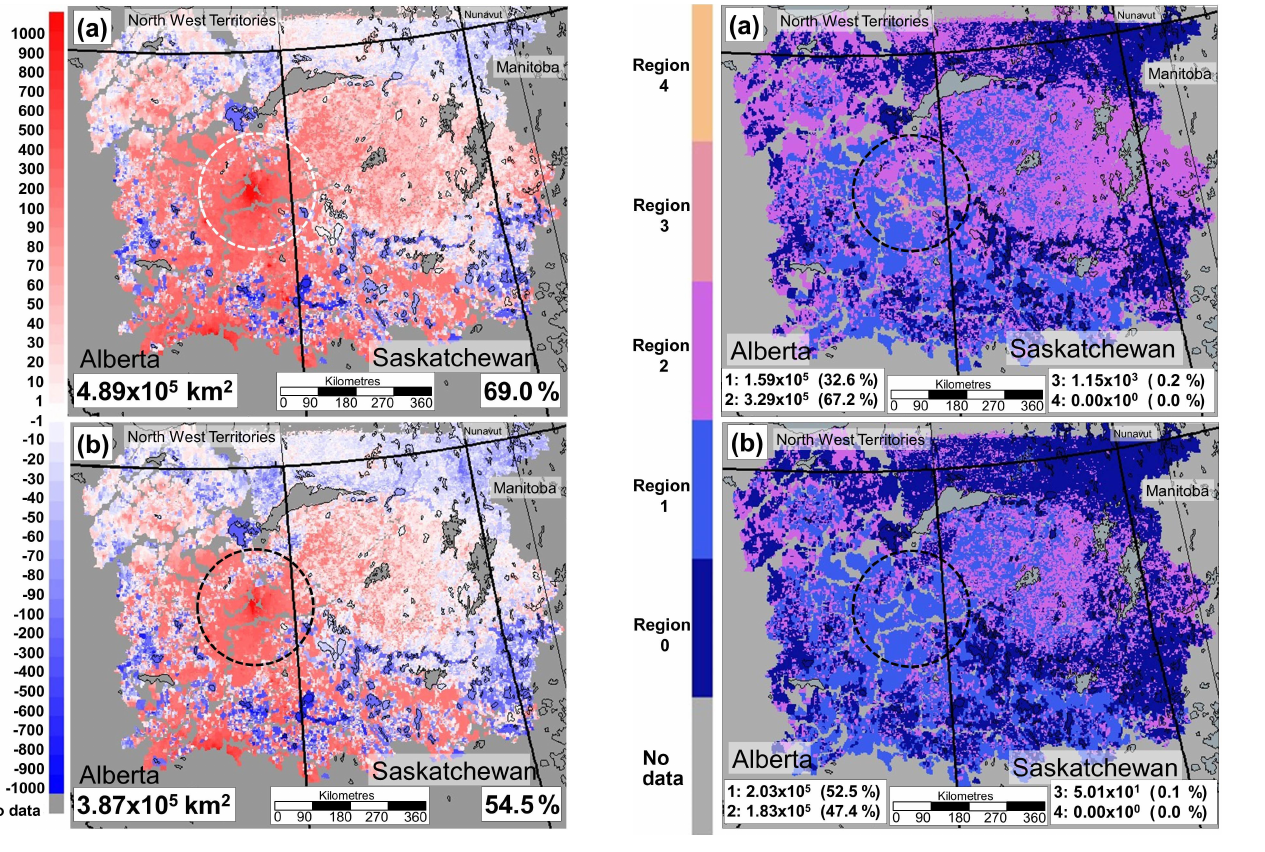
Figure 20. Predicted sub-types of aquatic ecosystem critical load exceedance (see Fig. 2), with respect to deposition of sulfur and nitrogen deposition. Boxed numbers give the area in exceedance within each of exceedance sub-types 1, 2, 3, and 4 (km 2 ) and the corresponding percentage of the total area in exceedance. (a) Calcu- lated using original model sulfur and nitrogen deposition estimates. (b) Calculated using model S dep and N dep estimates corrected to match precipitation observations. Circled region: 140km radius di- ameter circle around the Athabasca oil